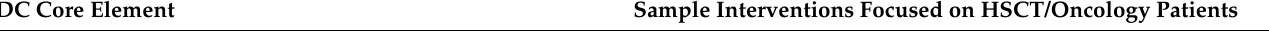
Table 1. Examples of ASP Interventions Specific to Oncology Patients Aligned with CDC Core